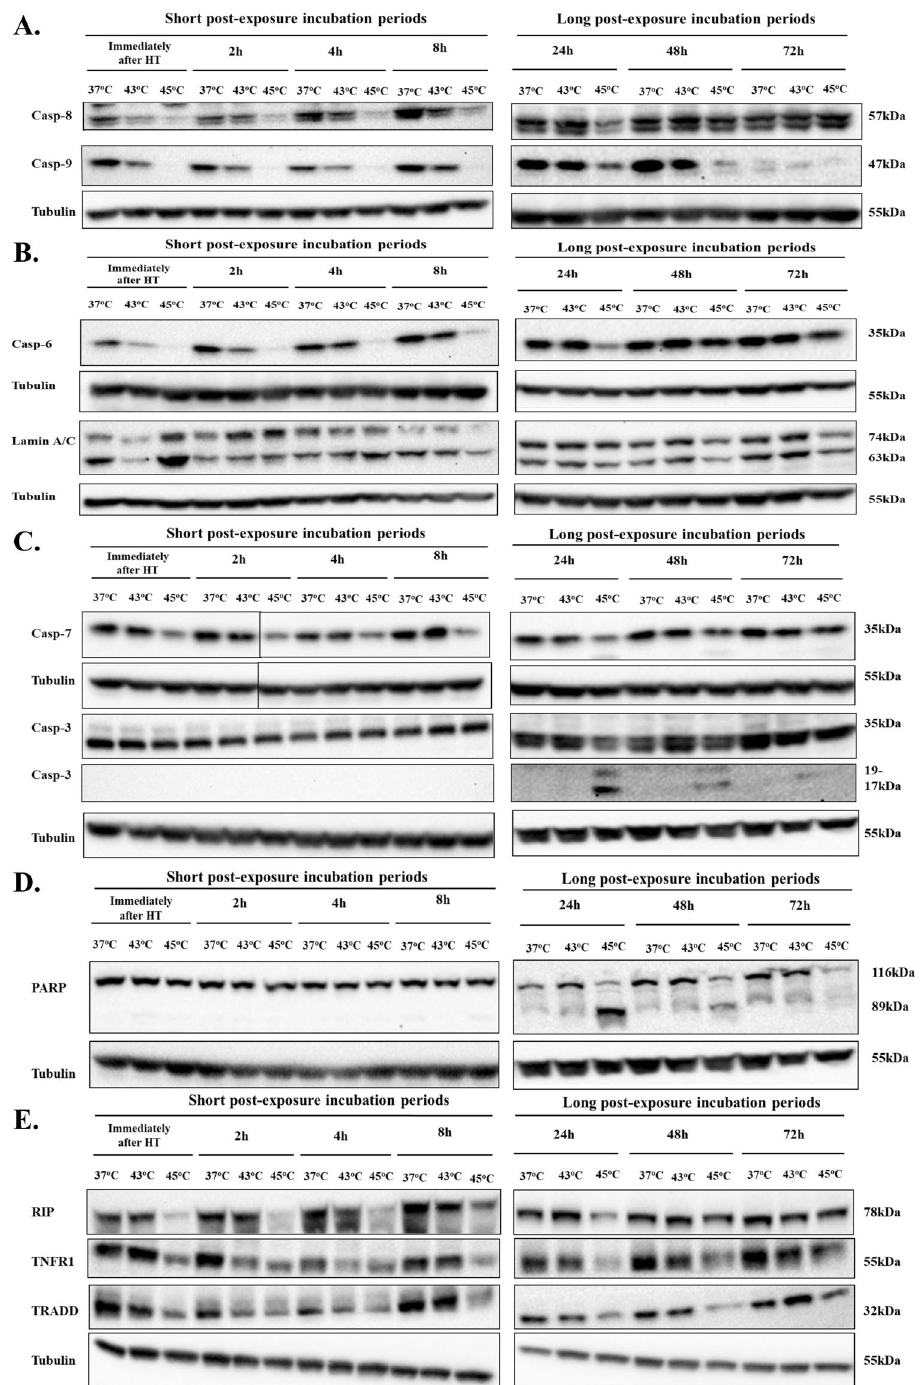
Figure 4. Hyperthermia-induced apoptosis in a human malignant melanoma (A375) cell line. The effect of hyperthermia on protein content of ( A ) caspases-8 and -9; ( B ) caspase-6 and lamin A/C; ( C ) caspases-7 and -3; ( D ) uncleaved/cleaved PARP; and ( E ) RIP, TNFR1, TRADD. Cells were grown overnight at 37 °C followed by exposure to hyperthermia, for 2 h, and then transferred back to 37 °C for the indicated post-exposure incubation times (2–72 h). Cell lysates were prepared and subjected to western blotting. Control cells were kept at 37 °C. β -tubulin was used as loading control. Samples from short and long-post exposure incubation periods following hyperthermia were electrophorized on separate gels. Delineation shows blots cropped from different areas of the same blot or different blots. Full-length blots are provided in Supplementary Material (Fig. 1S & 2S). Data shown is representative of at least two independent